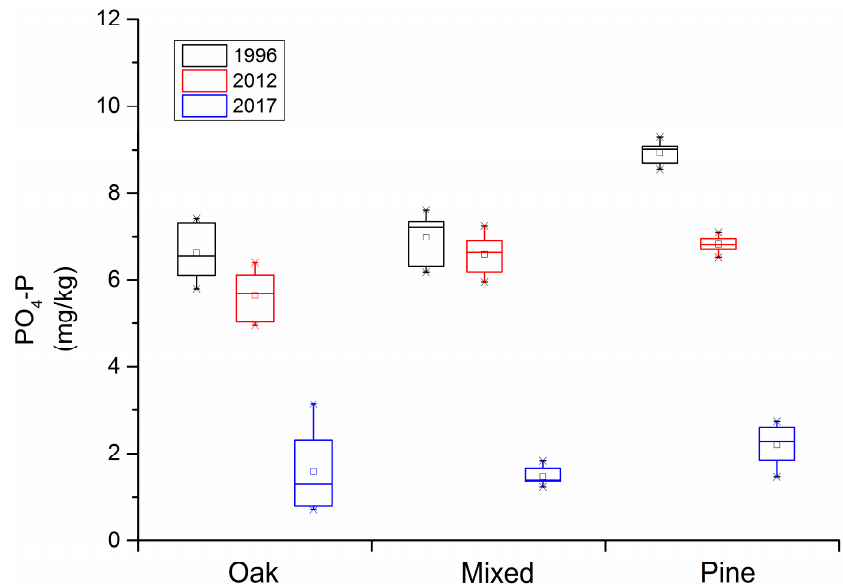
Figure 2. The loss of soil available phosphorus (P) along a 20-year time scale in the Qinling Mountains forest ecosystem. “AP” represents the soil available P, “Pinus” represents the P. armandii forest, “Mingled: represents the mixed Q . var. acuteserrata and P. armandii forest, and “Quercus” represents the Q . var. acuteserrata forest.